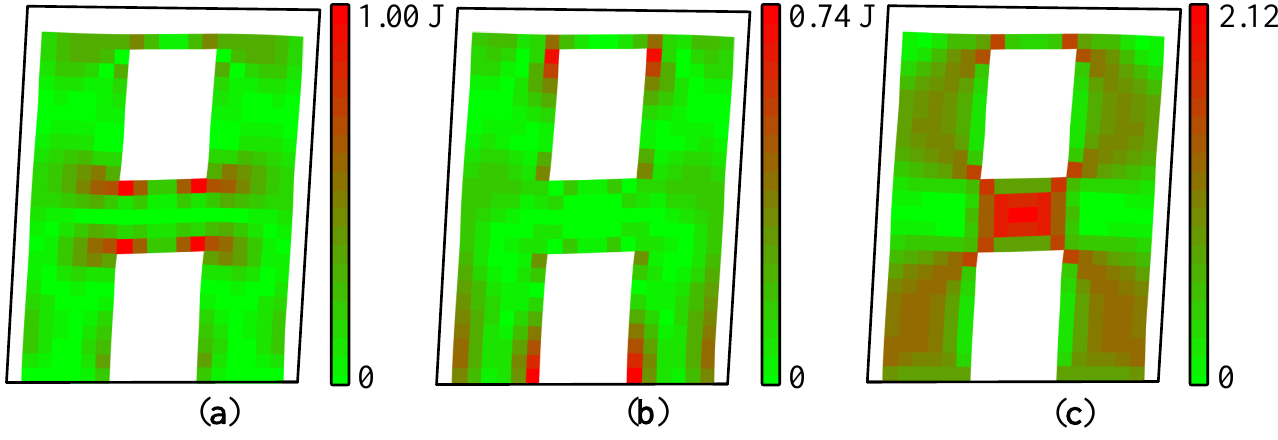
Figure 7. Modal strain energy cloud diagrams of A1: ( a ) X-direction modal normal strain energy, ( b ) Y-direction modal normal strain energy, and ( c ) modal shear strain energy.